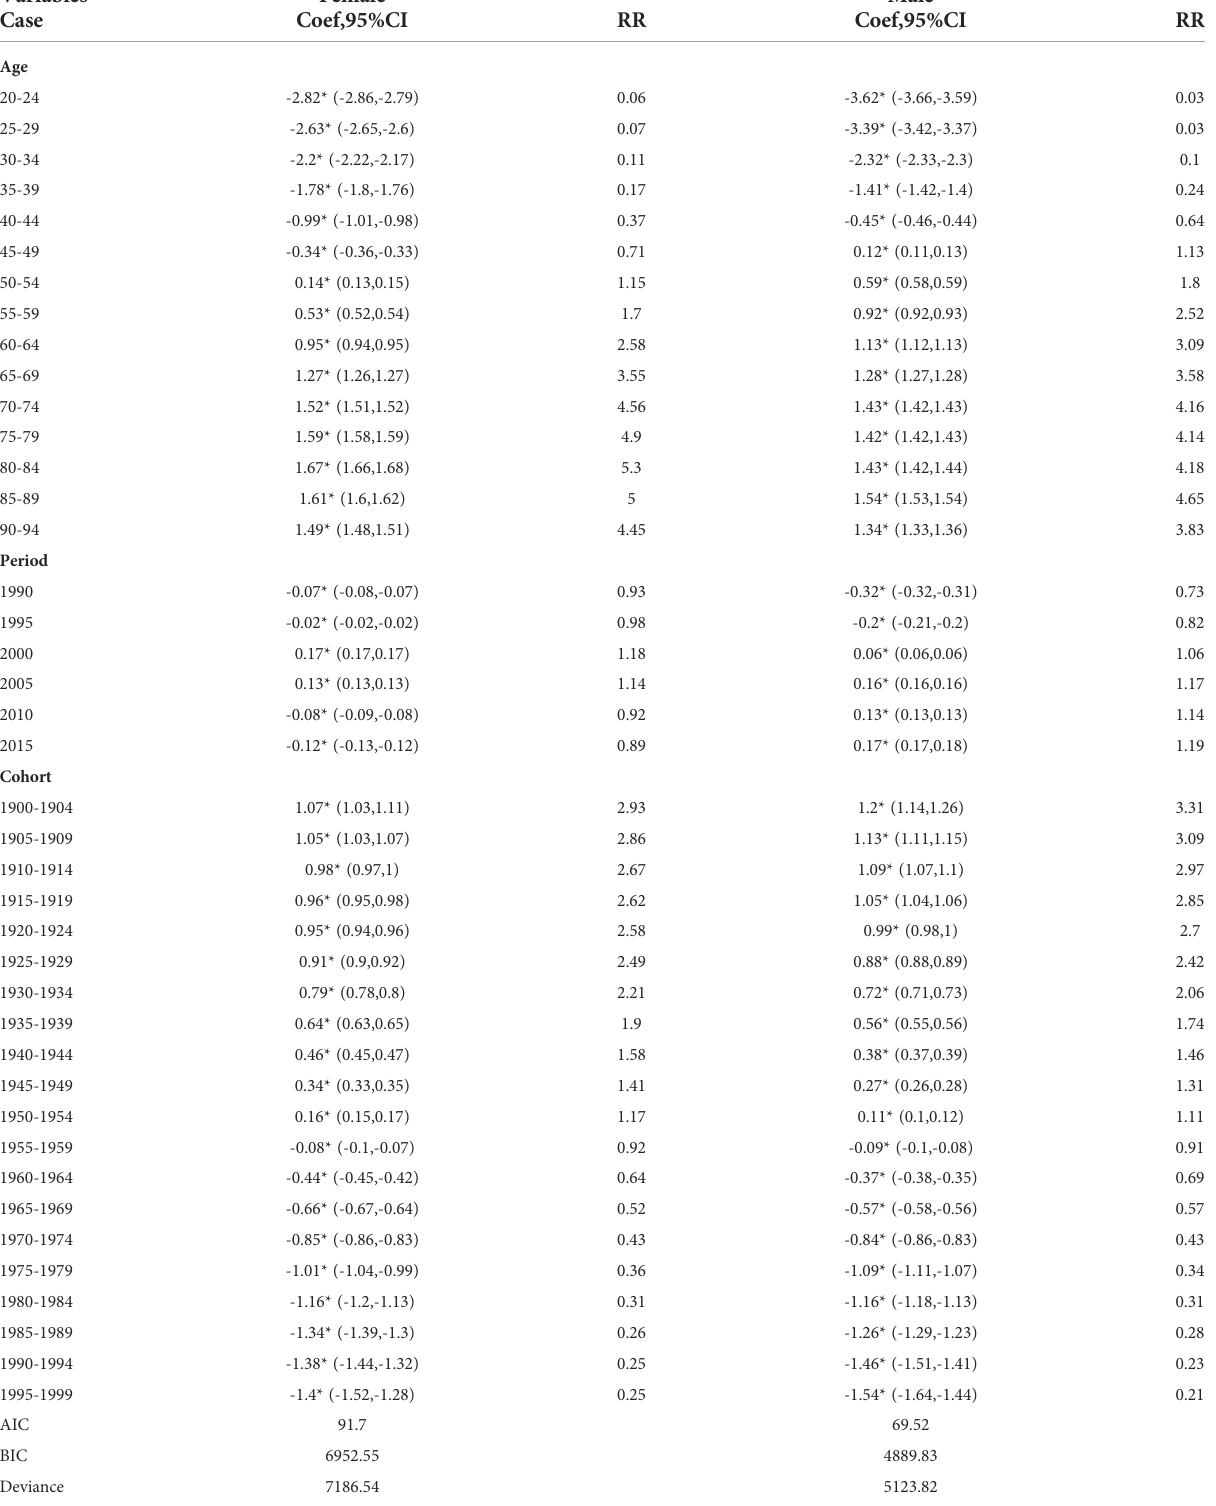
TABLE 3 Age – period – cohort (APC) model analysis results of esophageal cancer incidence in